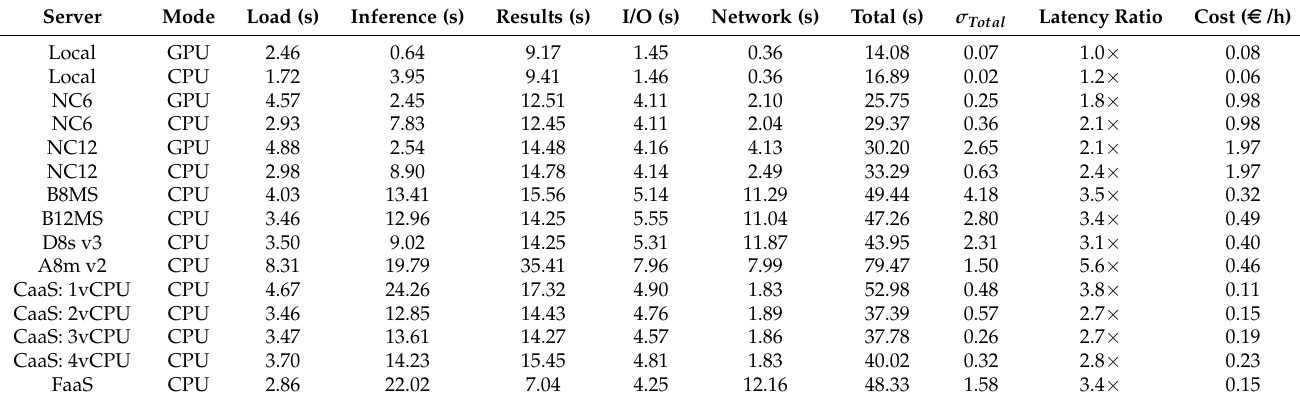
Table 6. Results of the SUT evaluation in several infrastructures using a batch of one hundred 416 × 416 images.